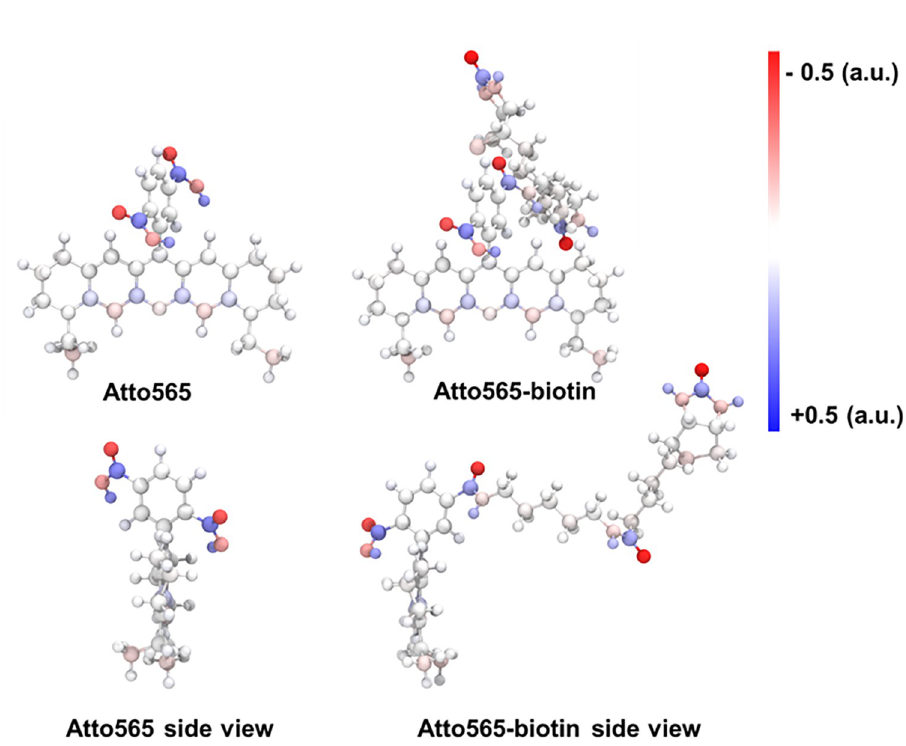
Fig 9. Lowest enegry conformations of the DFT-minimized structures. The red and blue colors represent the atomic charge range of -0.5 and +0.5 respectively.